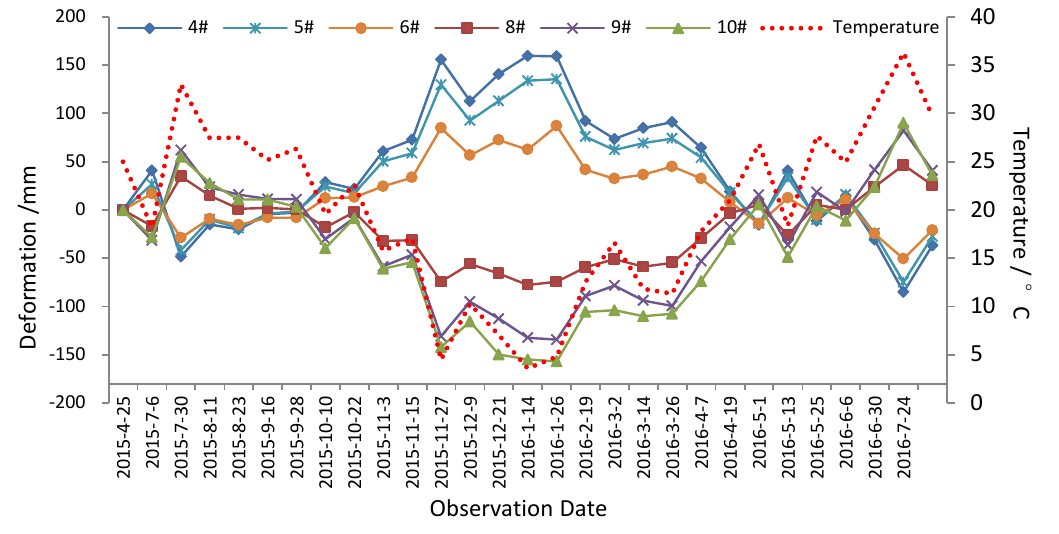
Figure 7: Longitudinal displacement time series at 6 piers and image acquisition temperatures.